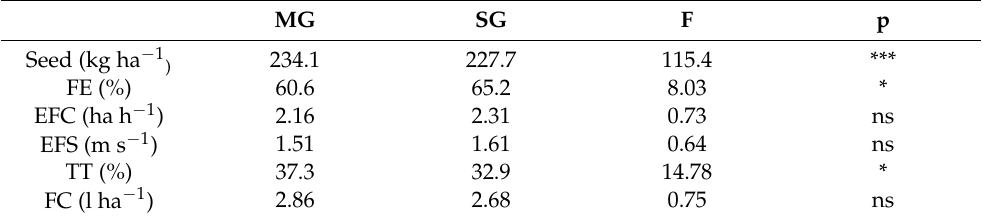
Table 4. Analysis of variance considering seeds used per unit of surface (seed/ha), field efficiency (FE),